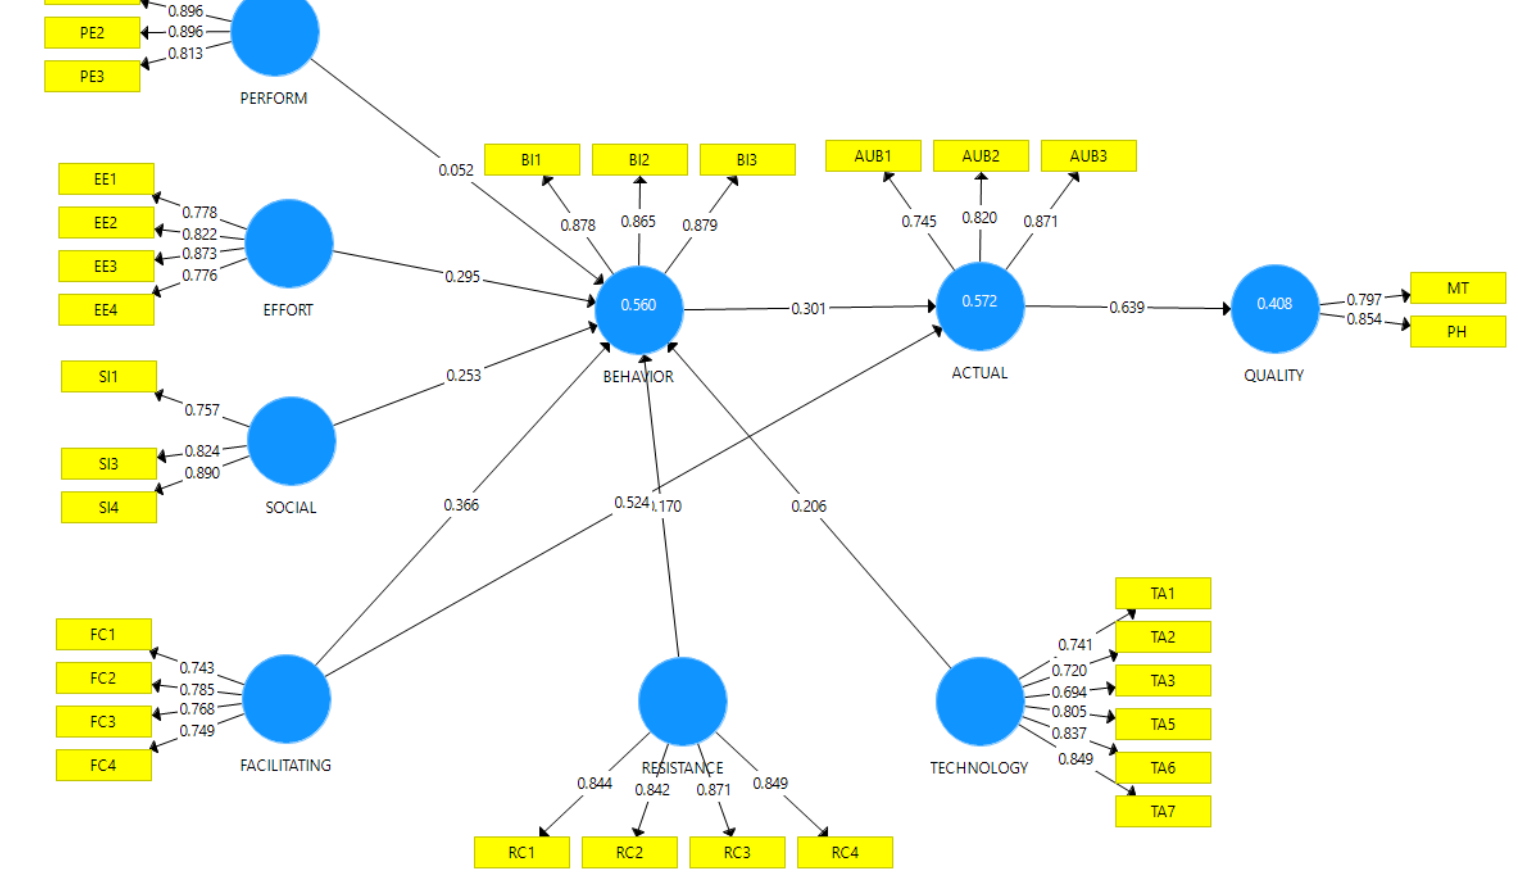
Figure 2. Diagram indicating the various latent and observed variables and their loadings.